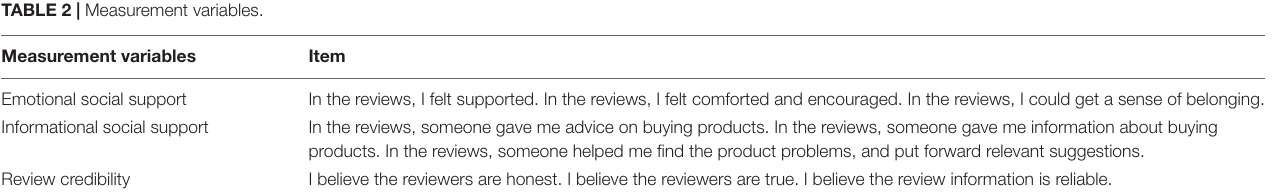
TABLE 2 | Measurement variables.